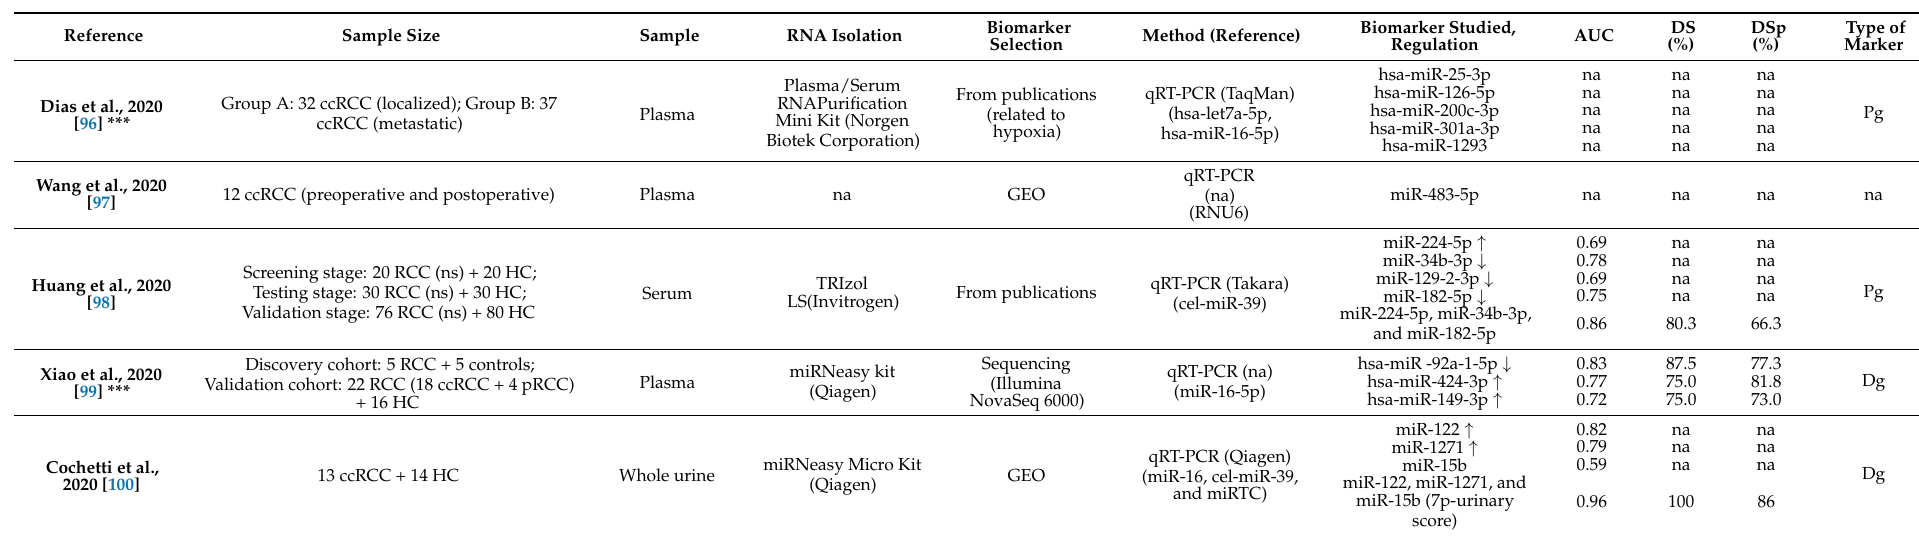
Low-Density Arrays; TCGA—The Cancer Genome Atlas; GEO—Gene Expression Omnibus; qRT-PCR—quantitative real-time PCR; AUC—area under the curve; DS—diagnostic sensitivity; DSp—diagnostic specificity; Dg—diagnostic; Pg—prognostic; na—not applicable/available; ns—not specified. ↑ / ↓ —upregulated/downregulated level of miRNAs; ** Multicenter studies; *** Authors investigated exosomal or microvesicles derived